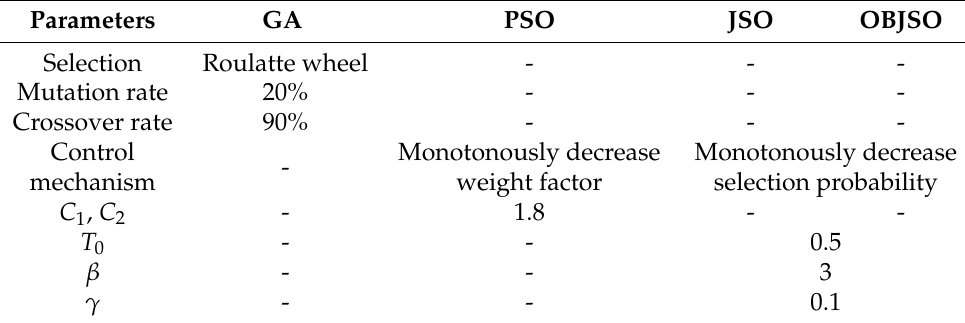
Table 5. Optimization parameter settings.